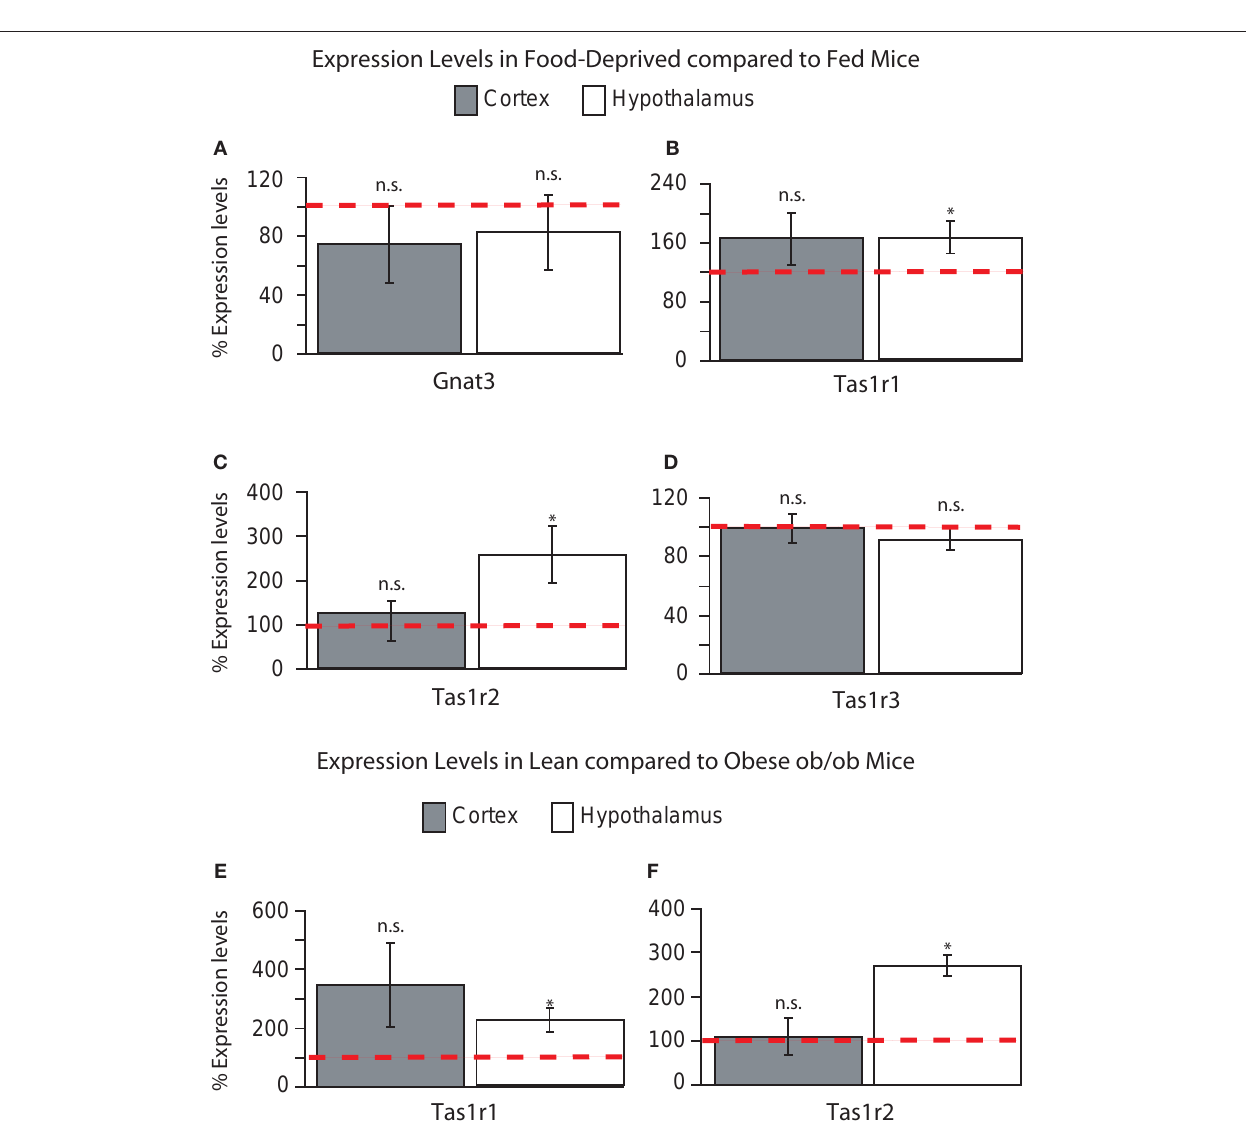
values < 100% imply that the brain region displayed relatively lower levels of expression in deprived compared to fed animals (see “Materials and Methods” for details). (A–D) Relative levels for taste receptor-related genes Gnat3, Tas1r1, Tas1r2 and Tas1r3 , respectively. Note signifi cant changes in Tas1r1 and Tas1r2 levels. (E–F) Taste receptor-related genes Tas1r1 and Tas1r2 were found to be expressed at signifi cantly higher levels the hypothalamus, but not cortex, of lean animals when compared to obese, hyperglycemic ob/ob mice. Data are expressed as percent levels of expression in the deprived animals compared to the fed animals, with 100% representing baseline (no relative change) levels. Panels show relative levels for taste receptor-related genes Tas1r1 (E) and Tas1r2 (F) . The other genes did not show signifi cant changes in expression levels. (*All p < 0.05, one-sample t -test against 100%). Dashed red line depicts the 100% baseline